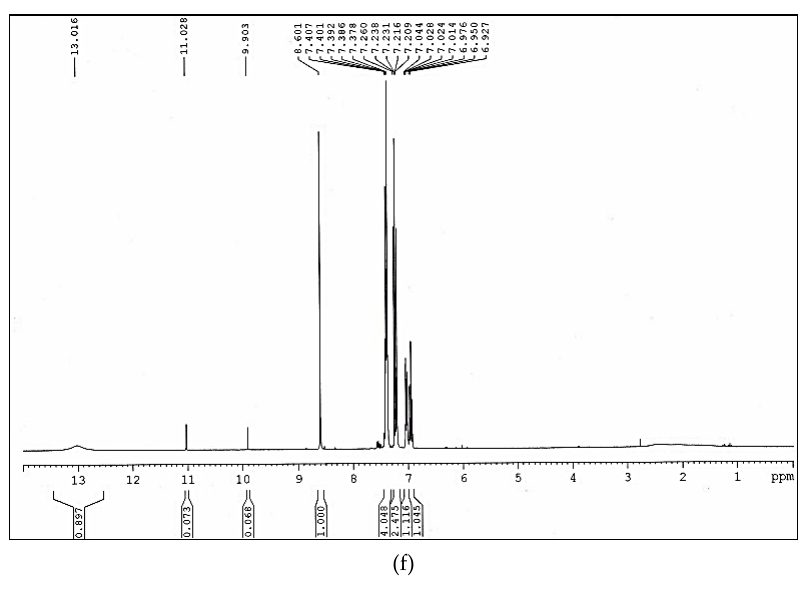
Figure 1. Fourier transform infrared spectroscopy (FT-IR) ( a – c ) and proton nuclear magnetic resonance ( 1 H NMR) spectra ( d – f ) for modifiers A, B, and C.